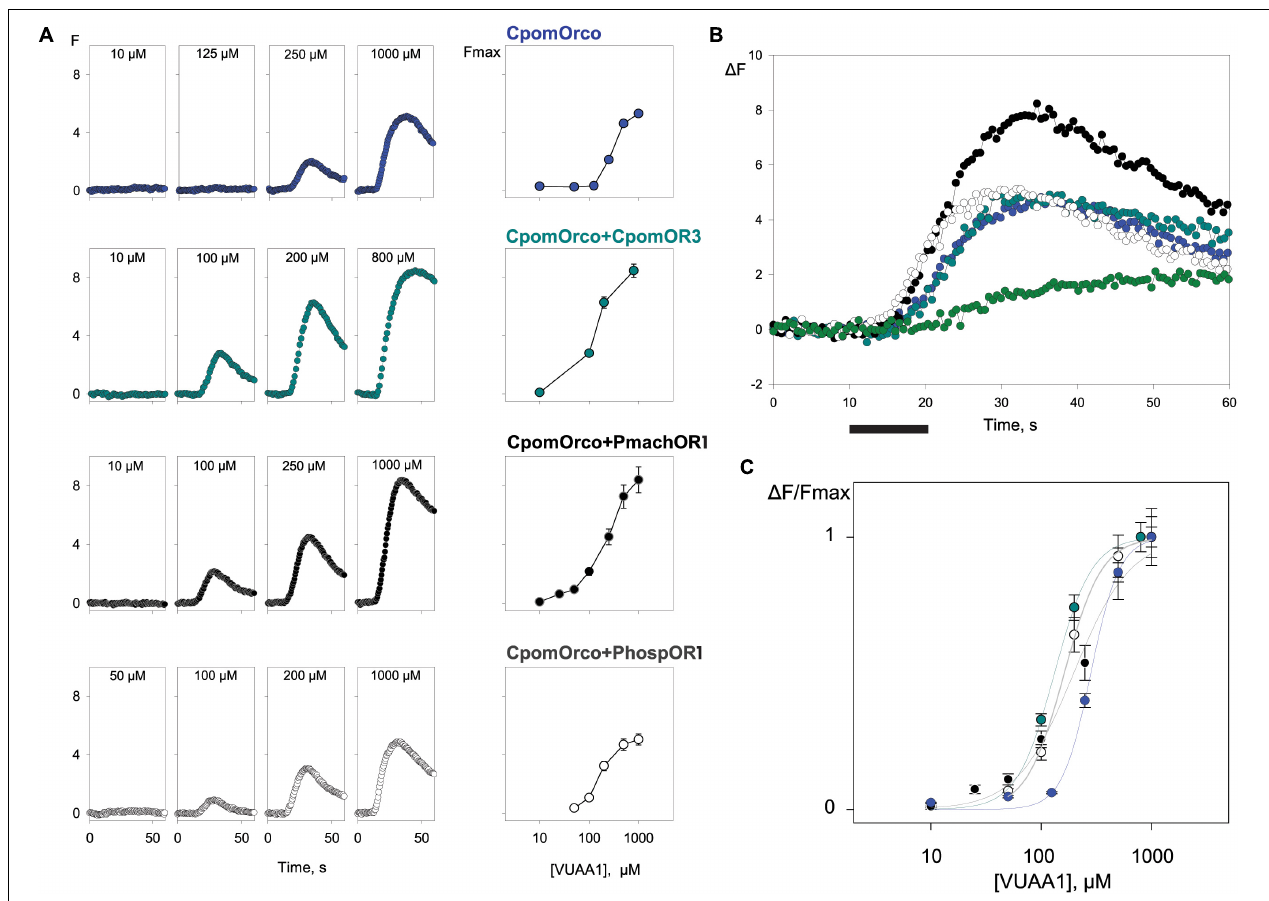
FIGURE 5 | Comparison of HEK293A cell responses expressing CpomOrco, CpomOrco + OR3 and chimeric CpomOrco + PapilioOR1. (A) Universal Orco agonist, VUAA1, elicits dose-dependent Ca++ i increase in HEK293A cells expressing homomeric or heteromeric CpomOrco. Data points represent the mean response amplitudes. Left: response to single doses of VUAA1 (as indicated within panels); right: dose-response plot. (B) Plot of the mean response to 500 µ M VUAA1: blue, CpomOrco ( N = 246); dark cyan, CpomOrco + OR3 ( N = 240); black, CpomOrco + PmachOR1 ( N = 55); white, CpomOrco + PhospOR1 ( N = 63); green, CpomOrco + OR3 to 1,000 µ M pear ester ( N = 134). Black bar: stimulus (10 s). (C) Normalized VUAA1 concentration dependencies. Data were fit to a Hill equation for CpomOrco (blue, EC50 = 282 ± 0.13 µ M, Hill coefficient ∼ 3.34 ± 0.47, N = 269), CpomOrco + OR3 (green, EC50 = 132.2 ± 3.15 µ M; Hill coefficient ∼ 2.5 ± 0.15, N = 123), CpomOrco + PmachOR1 (dark gray, EC50 = 197.2 ± 34.5 µ M, Hill coefficient ∼ 1.7 ± 0.33, N = 68) and CpomOrco + PhospOR1 (light gray, EC50 = 162 ± 6.64 µ M, Hill coefficient ∼ 2.5 ± 0.23; N =